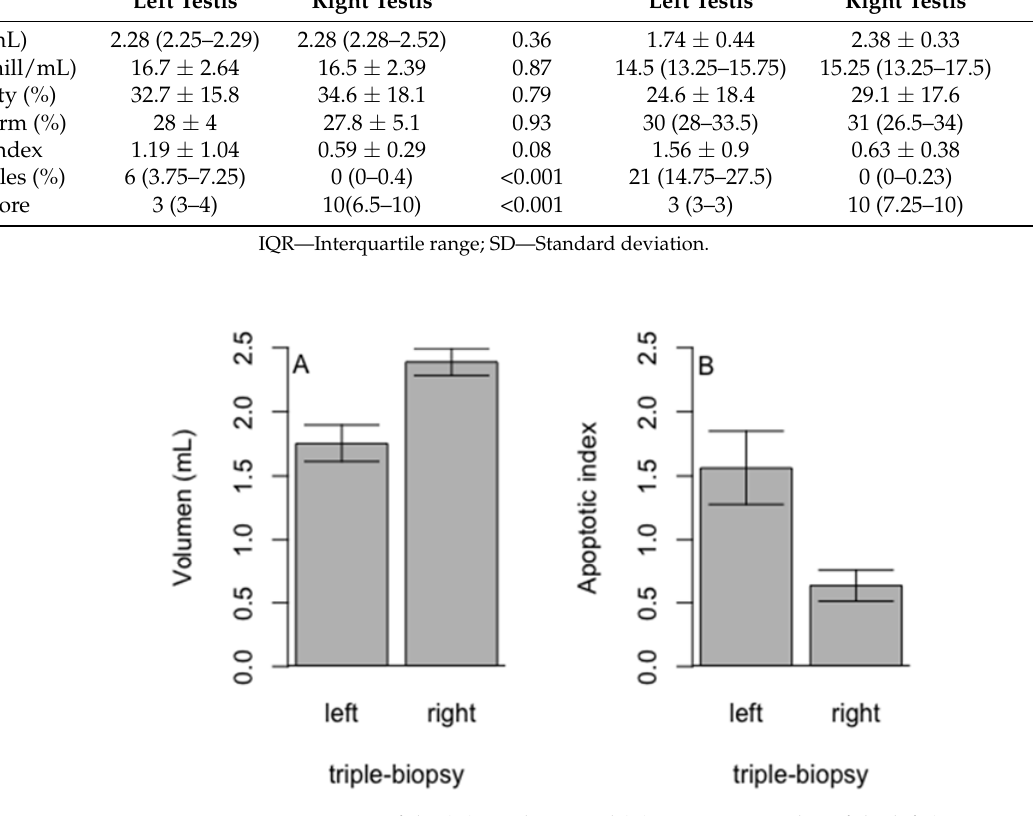
Table 2. Comparison between left (punctured) and right (intact) testicles in single and triple-biopsy groups.